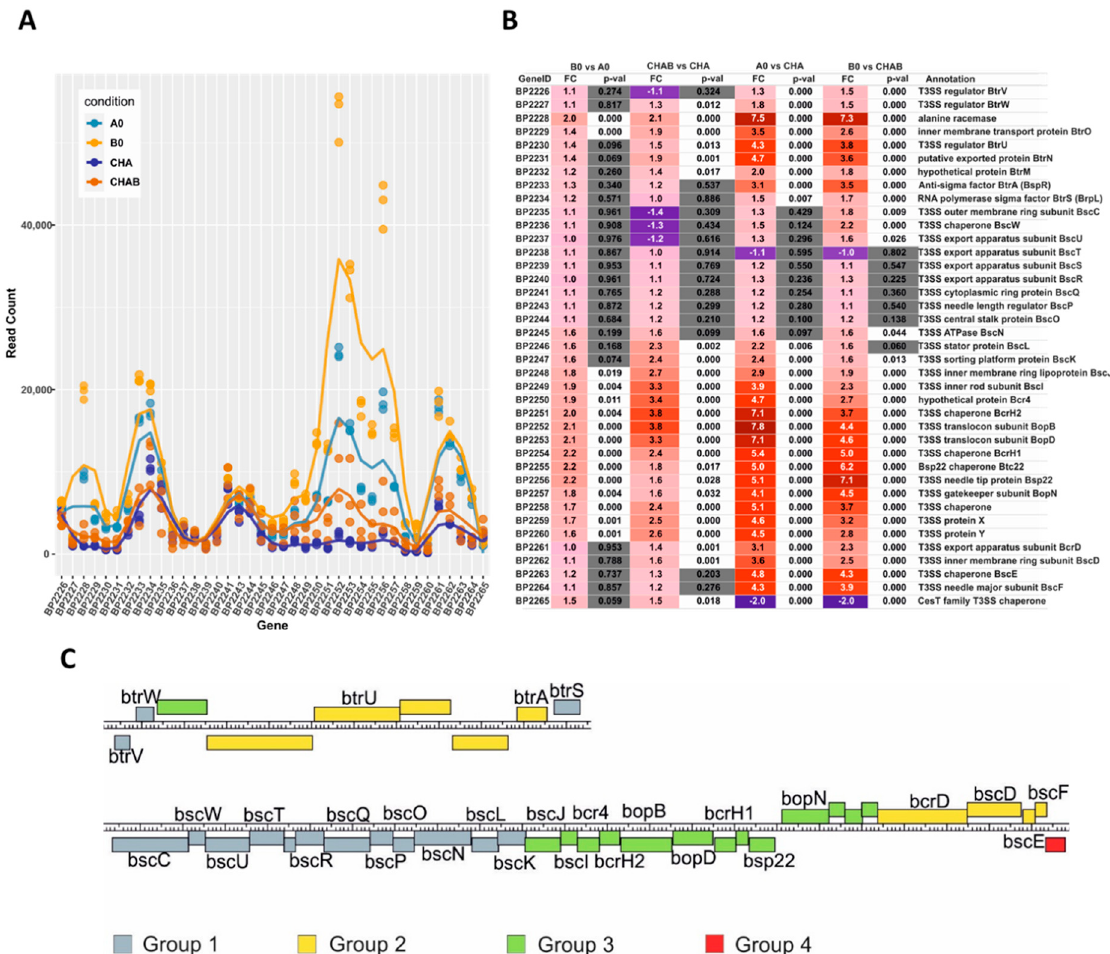
Figure 5. Transcriptional response to blood exposure is not uniform among T3SS genes. The expression of genes within bsc/btr loci was analyzed in cells that were either harvested directly from CHAB and CHA plates or from B0 and A0 liquid cultures. ( A ) Graph representing normalized read count for each gene within bsc/btr loci. Dots show the read count in triplicates of samples grown under four different conditions. Lines represent the smoothed averages of the read counts in triplicates. ( B ) Differential gene expression analysis of bsc/btr loci. Gradient represents fold changes of gene expression between different conditions. Blue and red colors represent downregulation and upregulation of corresponding genes; respectively, color intensity indicates the extent of the modulation. Cells filled with gray color denote that the change in expression of the corresponding gene is not significant ( p -value > 0.05). ( C ) Grouping of T3SS genes within btr (upper panel) and bsc (lower panel) loci according to their gene expression profiles under different growth conditions. Genes are depicted as color-coded blocks based on the affiliation to the corresponding group; their position indicates the stranded- ness.